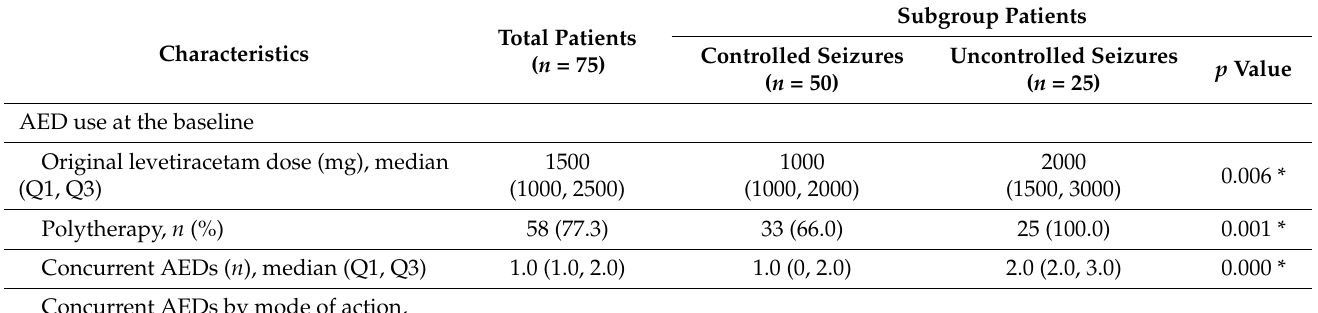
Table 2. Antiepileptic drug treatment of total patients and patient